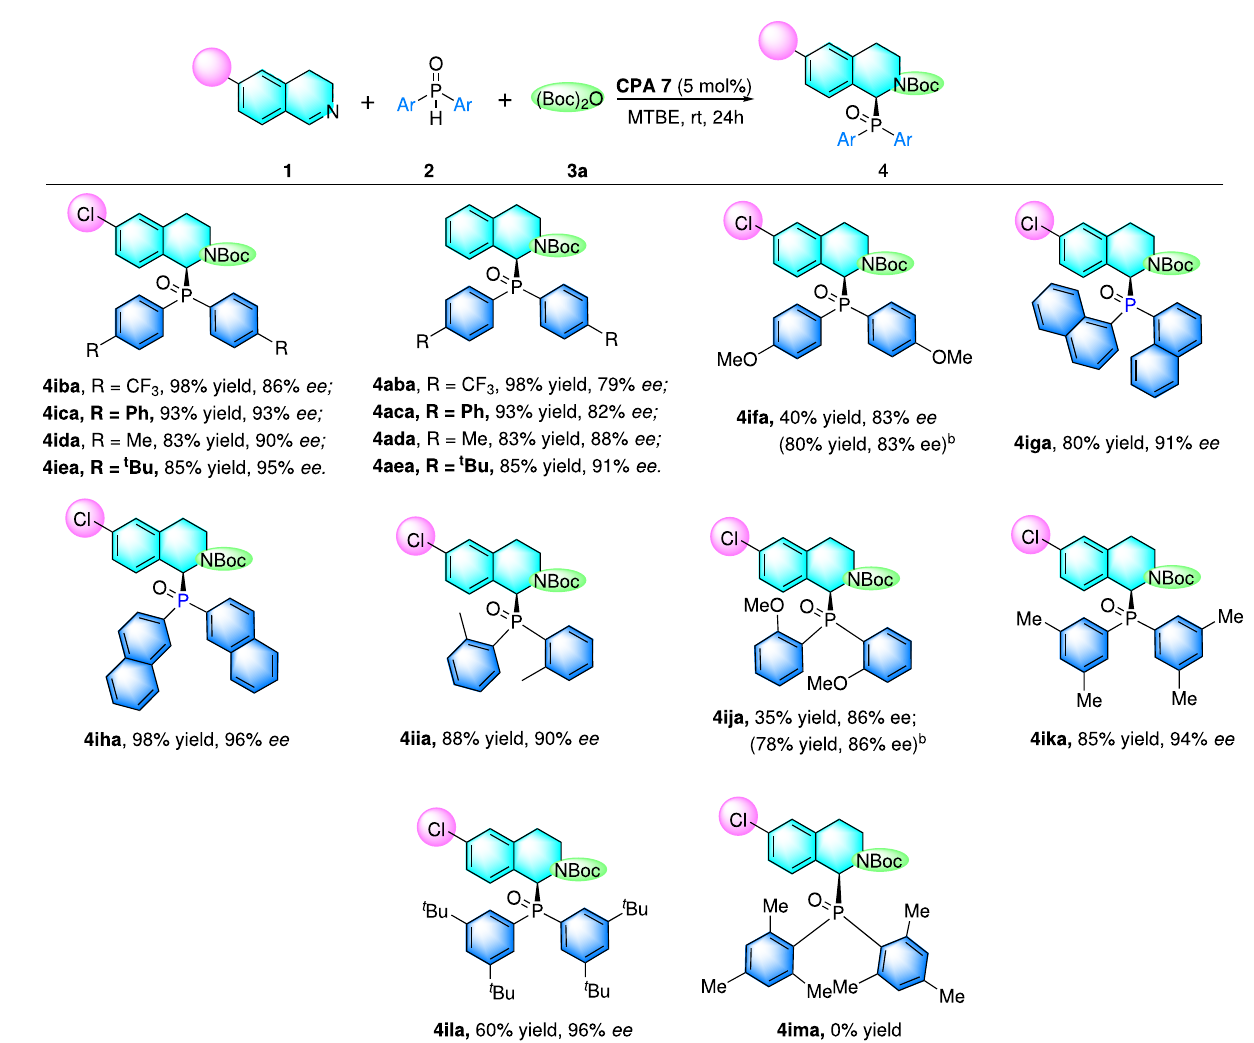
Fig. 3 Scope of secondary phosphine oxides. a Reaction conditions: 1 (0.2 mmol), Boc 2 O 3a (0.3 mmol) and CPA 7 (5 mol%) at 50 °C for 0.5 h. 4 Å MS (50 mg), MTBE (2 mL) and 2a (0.24 mmol) was added, and the mixture was stirred at room temperature for 24 h. Isolated yields were given here and ee value was determined by HPLC (Chiralcel OD-RH). [b] Benzene was used instead of